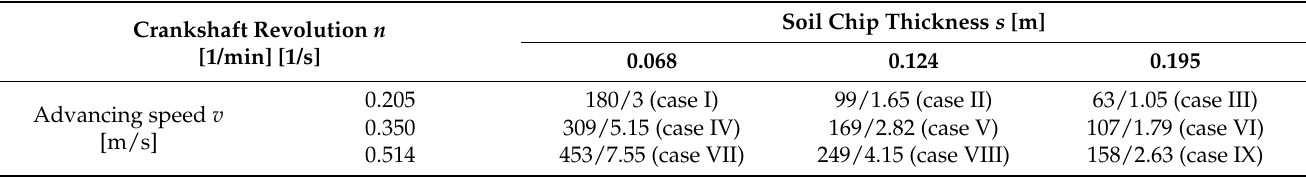
Table 2. Working parameters of the spade machine determining the nine simulation cases.